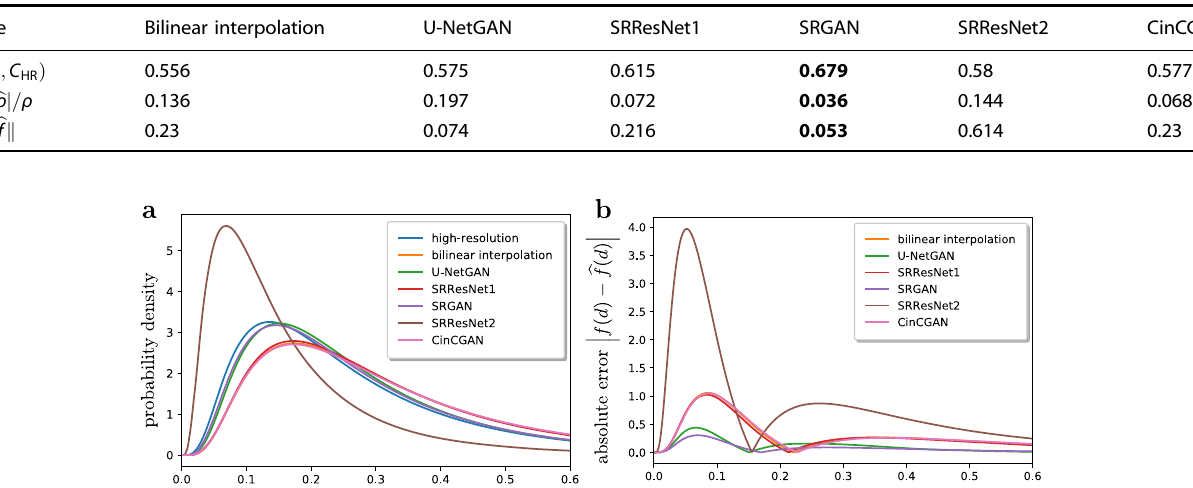
Table 3. Quantitative comparison of crack segmentation results., where the values of J ð b C HR ; C HR Þ , j ρ (cid:3) b ρ j = ρ and k f (cid:3) b f k obtained for SRGAN (marked in boldface) indicate that SRGAN allows for a better segmentation of cracks than upsampling using bilinear interpolation or super-resolving using the remaining four networks.